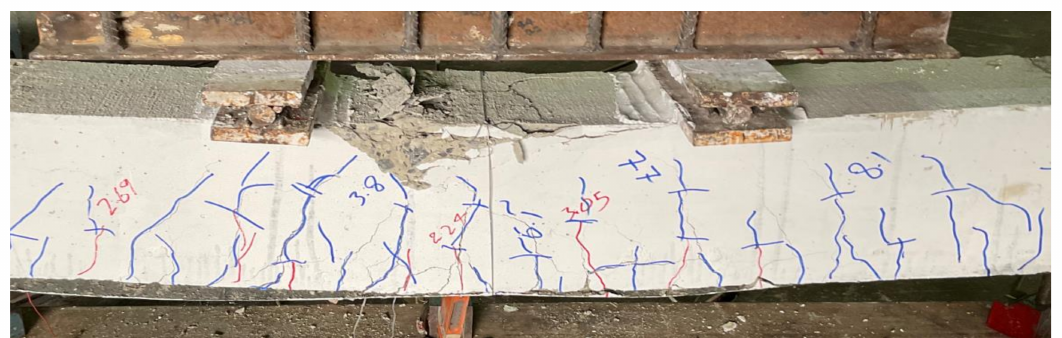
Figure 14. Excessive concrete crushing observed in beam